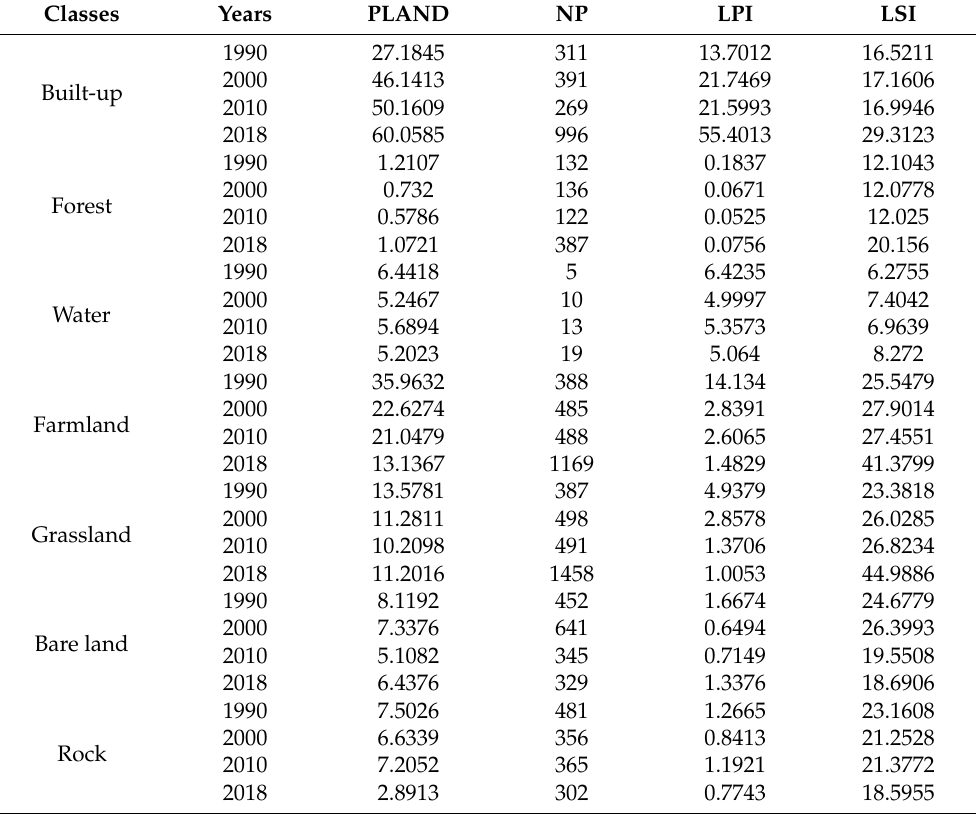
Table 9. Landscape metrics at class level in 1990, 2000, 2010, and